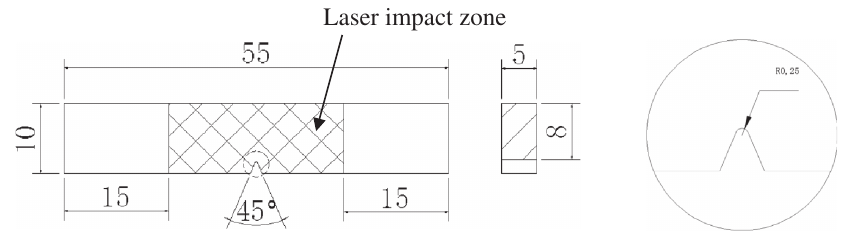
Figure 3: Schematic of the impact toughness